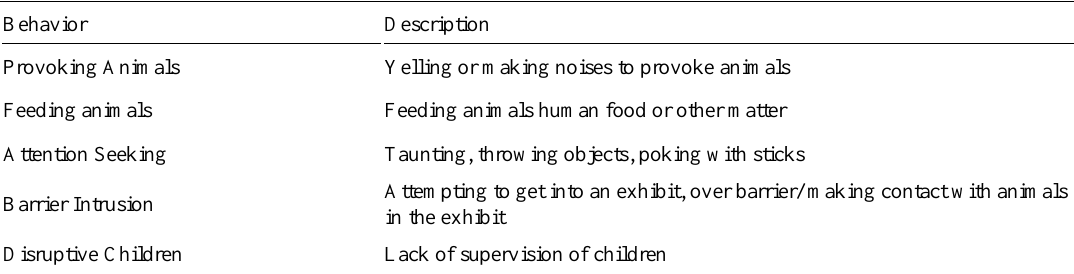
Description of Inappropriate Behaviors in Zoo Visitors Behavior